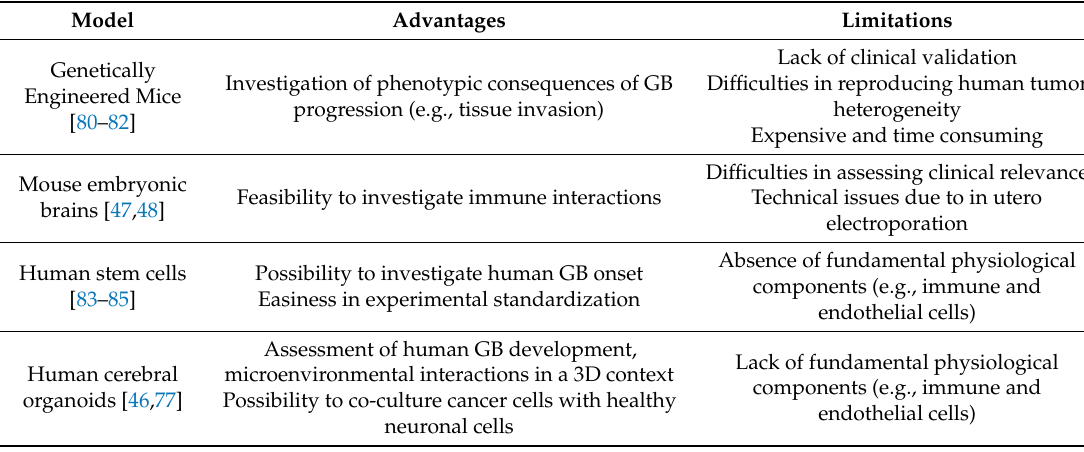
Table 1. Advantages and disadvantages of glioblastoma